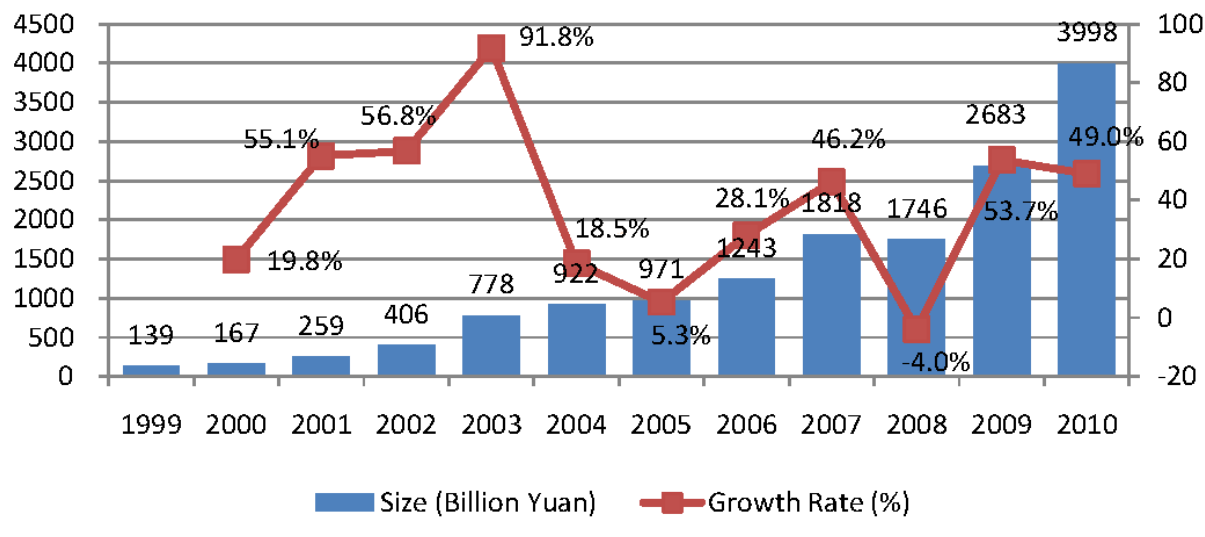
Figure 2. The change of land finance in China